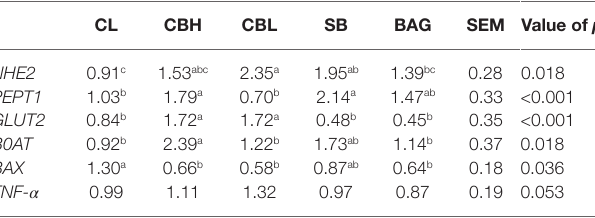
TABLE 8 | Jejunal gene expressions of yellow-feathered breeder hens. CL CBH CBL SB BAG SEM Value of p